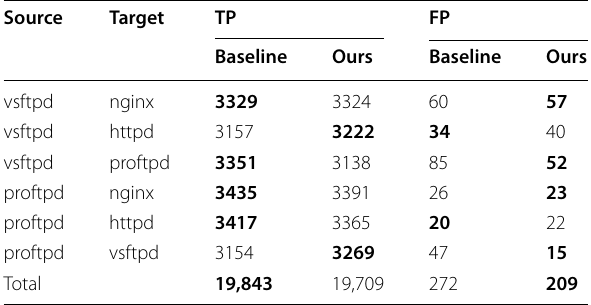
Table 4 Number of true positives and false positives of domain adaptation